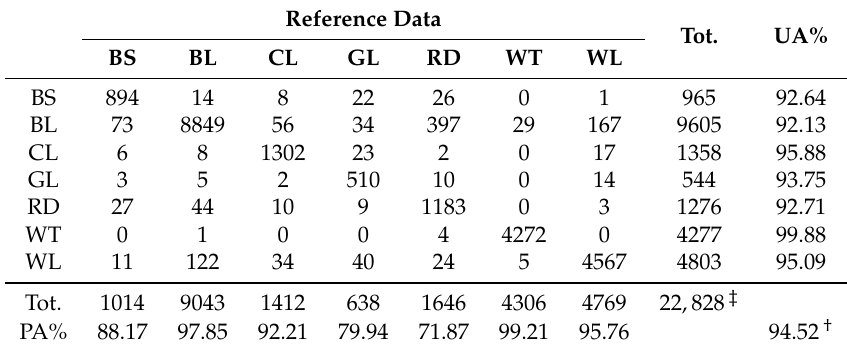
Table 7. Example confusion matrix for 7-class urban land cover classification derived from SPOT-5 image and its spatial information using the Random Forests classifier (Scenario